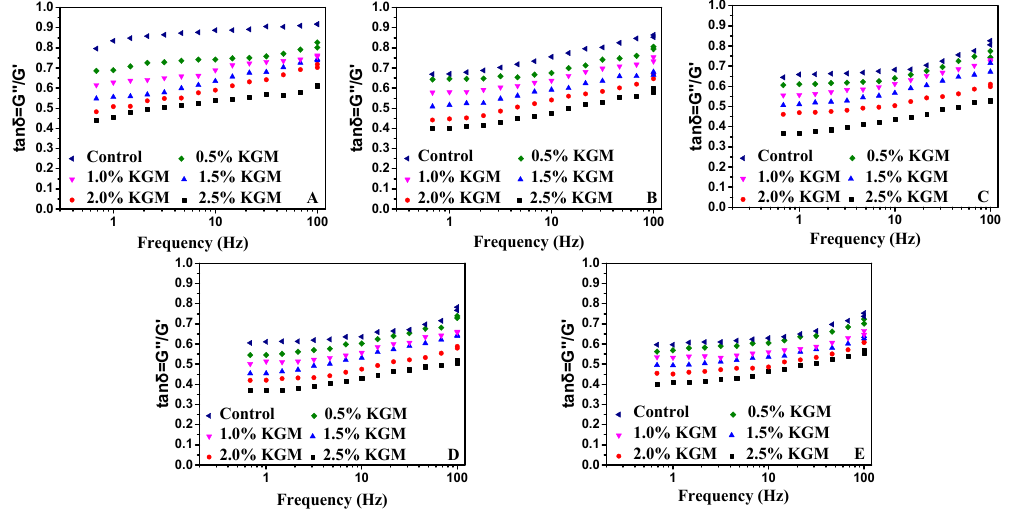
Figure 6. E ff ect of di ff erent proportions of KGM added on tan δ of frozen dough. 0 days frozen storage ( A ), 15 days frozen storage ( B ), 30 days frozen storage ( C ), 45 days frozen storage ( D ), 60 days frozen storage ( E ).